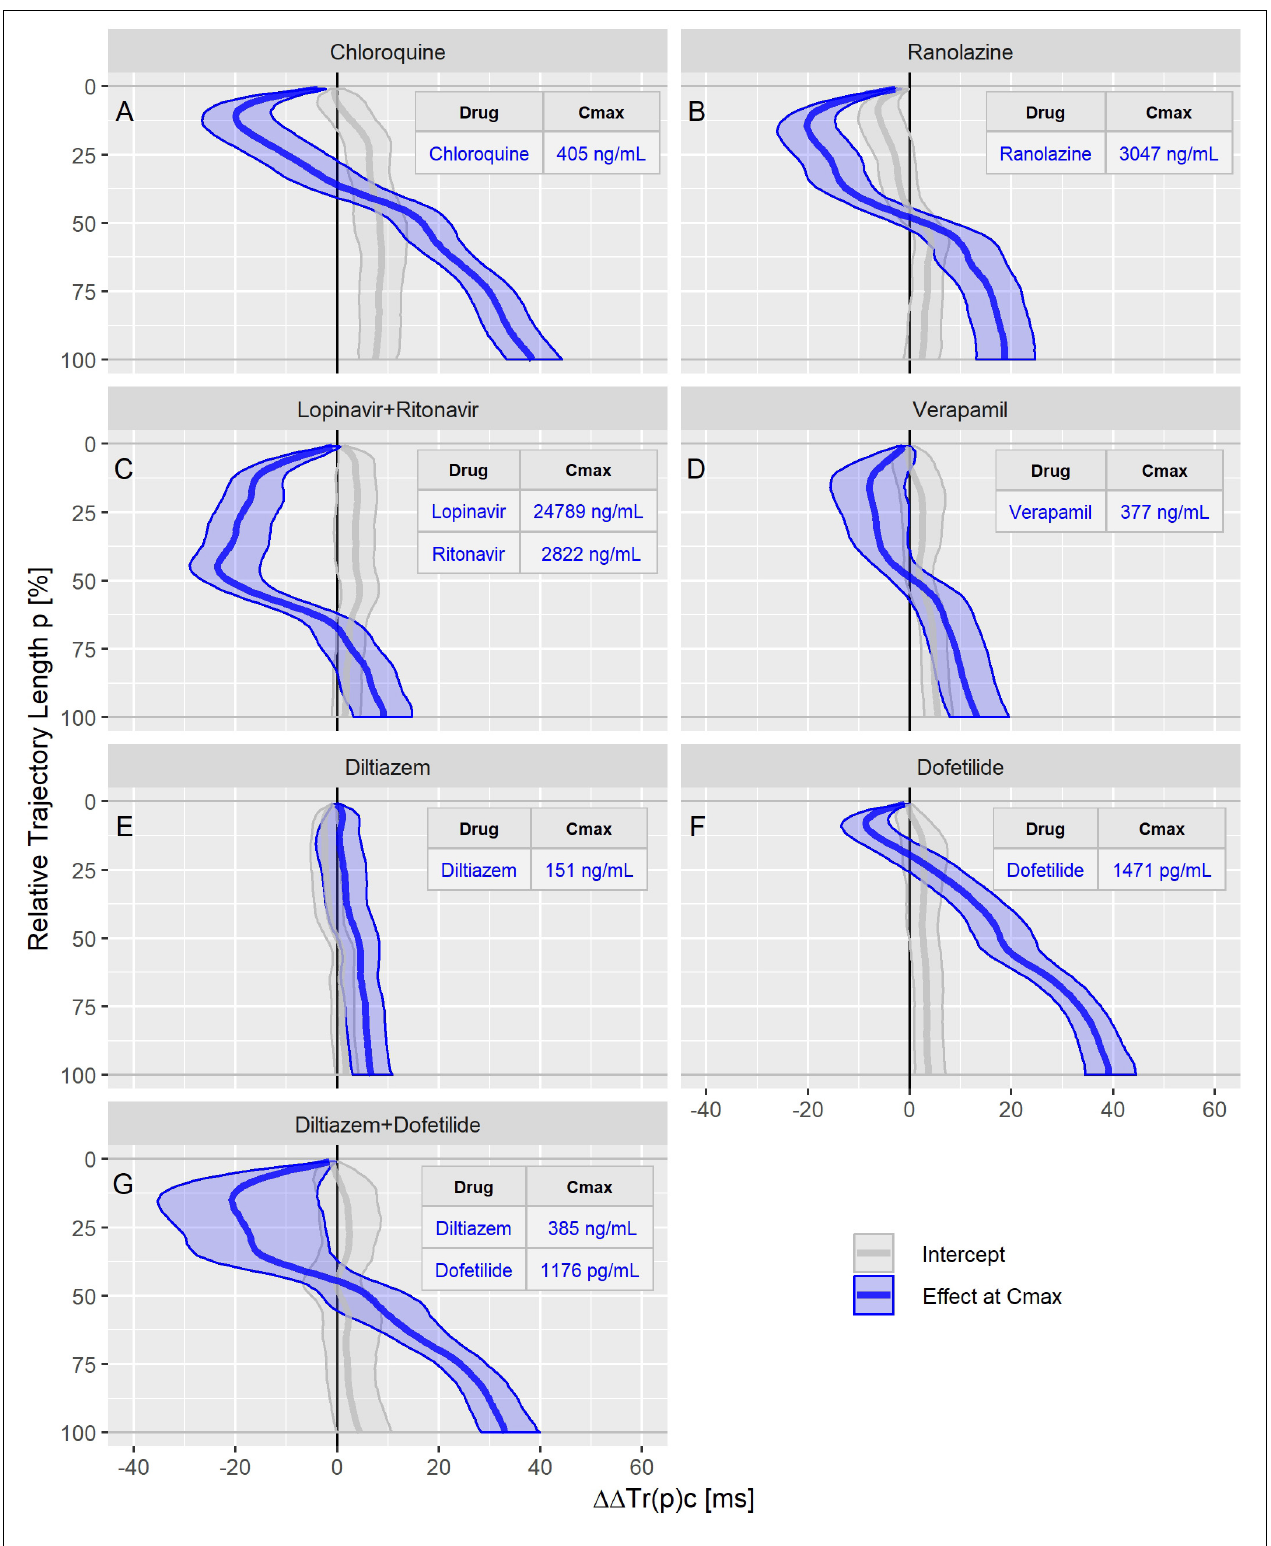
FIGURE 7 | Continuous drug effect profile estimates with 90% confidence bands for chloroquine (A) , ranolazine (B) , lopinavir plus ritonavir (C) , verapamil (D) , diltiazem (E) , dofetilide (F) , and diltiazem plus dofetilide (G) in study C. The blue bands denote the estimated drug effect for the drug’s maximum plasma concentration (Cmax). The gray bands are the model prediction at zero drug